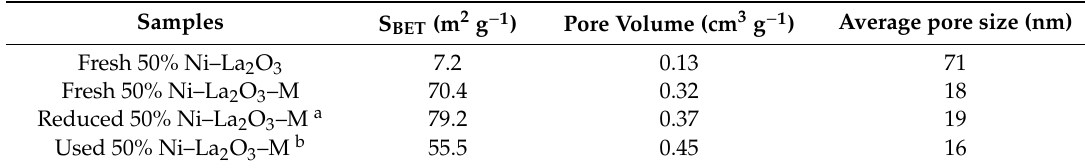
Table 1. Physical properties of 50% Ni–La 2 O 3 –M and 50% Ni–La 2 O 3 .